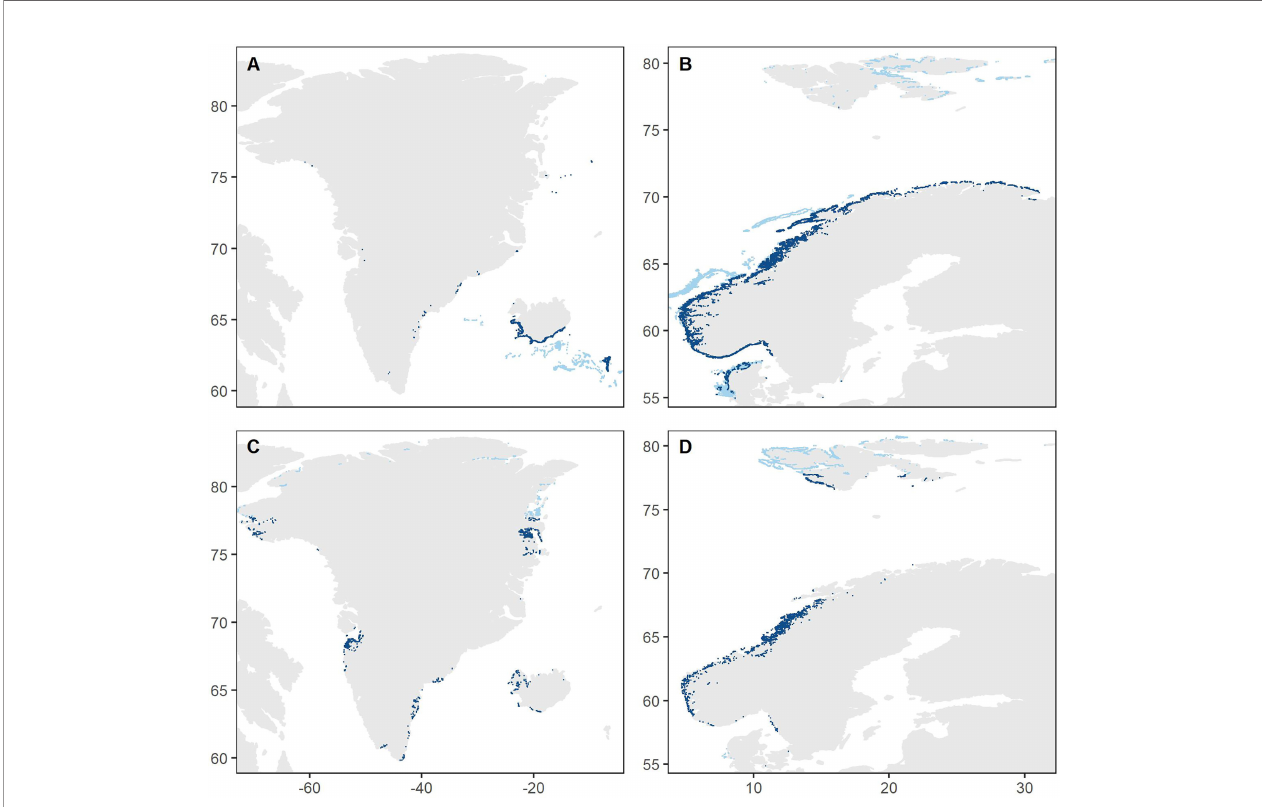
FIGURE 3 | Predicted presence (blue points) of Laminaria (A, B) and Saccharina (C, D) kelp forests (dense or moderately dense forest) across the Nordic region (panels A – D cover the western and eastern parts of the region, respectively). Light blue points illustrate predictions that are highly uncertain or unrealistic as they are either north of the northernmost observation, deeper than the deepest observation or in areas with unsuitable substrate (for Denmark). Areal distribution data are given both with and without these uncertain/unrealistic predictions ( Table 1 ). Note that the point size is increased to allow visualization at this large scale, resulting in an exaggerated impression of the areal extent.